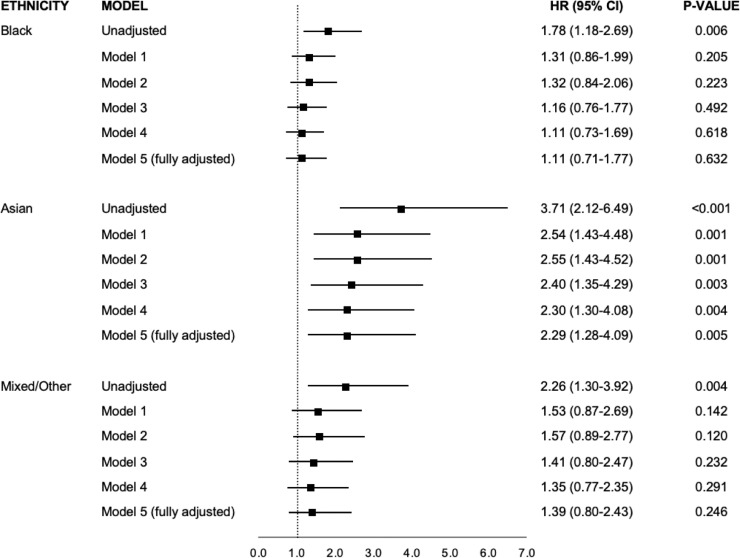
Association between ethnicity and risk of ICU admission with COVID-19.Hazard ratios are compared to White ethnicityModel 1 – adjusted for age and sexModel 2 – adjusted for age, sex and index of multiple deprivationModel 3 – adjusted for age, sex and cardiometabolic comorbidities*Model 4 – adjusted for age, sex, and all comorbidities**Model 5 (fully adjusted model) – adjusted for age, sex, index of multiple deprivation, and all comorbidities*Cardiometabolic comorbidities include: hypertension, coronary heart disease, heart failure, previous stroke/TIA, diabetes, chronic kidney disease.**Cardiometabolic comorbidities, asthma, chronic obstructive pulmonary disease.